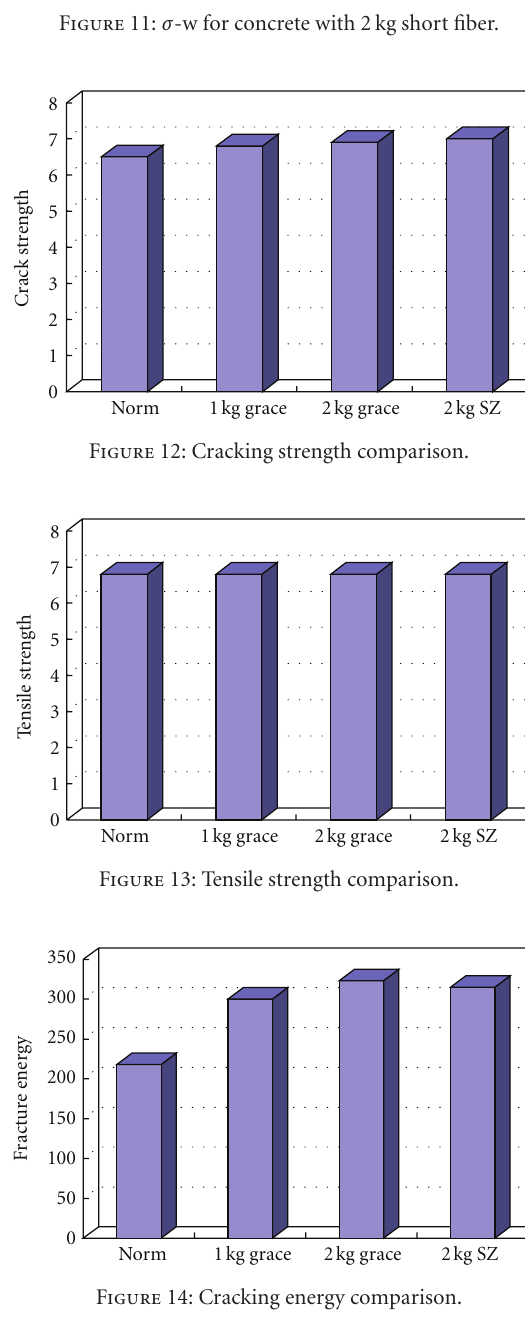
Figure 11: σ -w for concrete with 2kg short fiber.